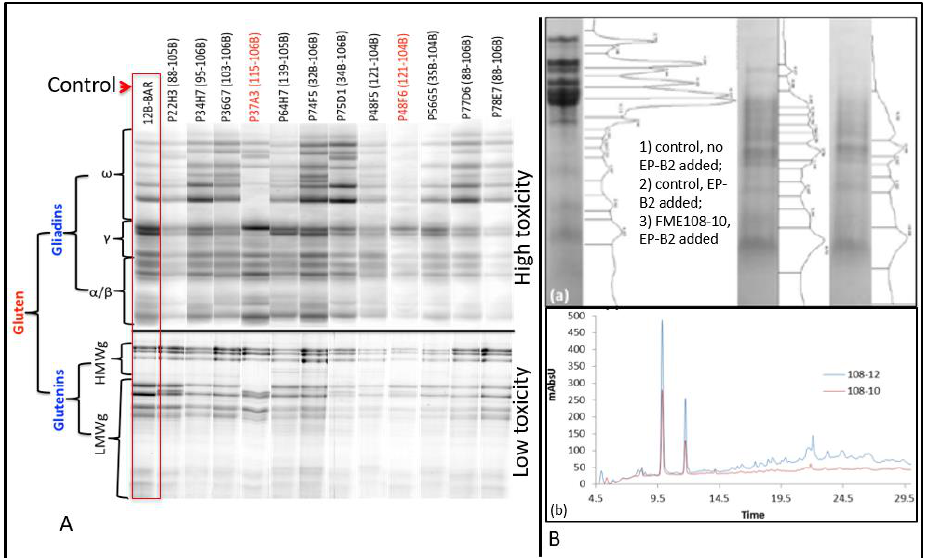
Figure 3. Genetically engineered wheat with reduced-gluten content ( A ) and expressing ‘glutenases’ in the wheat endosperm ( B ). Polyacrylamide gel electrophoresis of gliadins ( top ) and glutenin ( bottom ) fractions extracted from the grains of the 12 selected genetically engineered wheat lines ( A ). Differences in the degradation patterns of gluten proteins derived from a transgenic wheat line expressing Flavobacterium meningosepticum prolyl endopeptidase (FME108-10) and its untransformed sibling (FME108-12), under simulated gastro-intestinal conditions with endoprotease B isoform 2 (EP-B2) ( B ). Gradient tricine gel and densitometric analyses of the digested gliadin fraction derived from FME108-12 with no EP-B2 (left lane and trace), FME108-12 with EP-B2 (middle lane and trace), and FME108-10 with EP-B2 (right lane and trace) ( a ). Reversed-phase high-performance